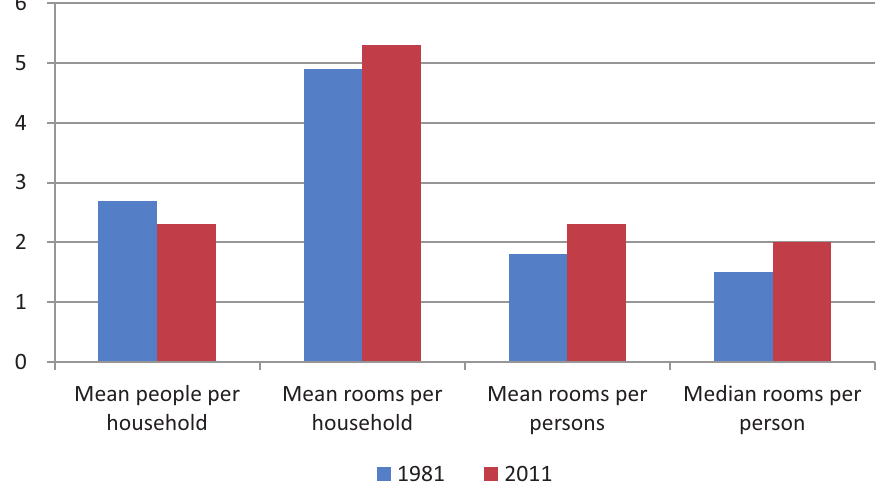
Figure 2. People, households, housing space and housing growth in England and Wales, 1981–2011. Compiled by the au- thor based on data from Casweb for 1981 and Nomisweb for 2011.